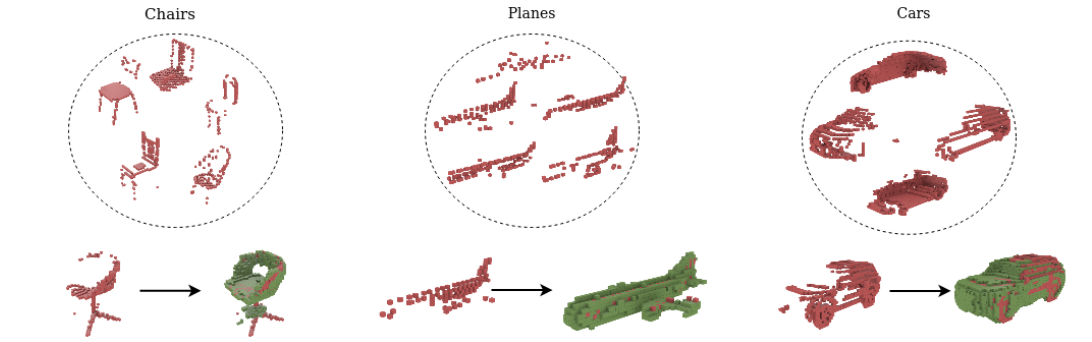
Figure 1. Our GAN learns to complete shapes from sparse observations (red voxels are observations, green voxels are predictions). Dai et al., 2017b, Wang et al.,